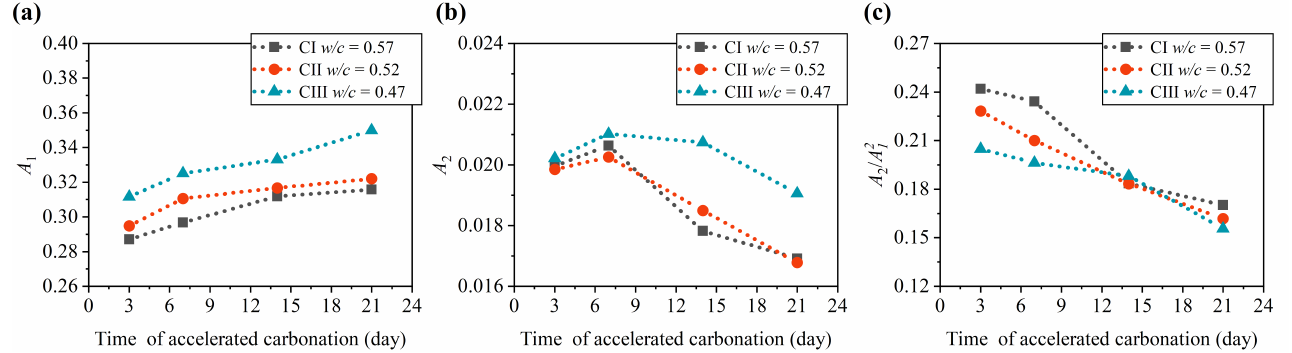
Figure 6. Variation of ultrasonic average parameters with carbonation time: ( a ) fundamental ampli- tude A 1 ; ( b ) second harmonic amplitude A 2 ; ( c ) nonlinear parameter A 2 / A 2